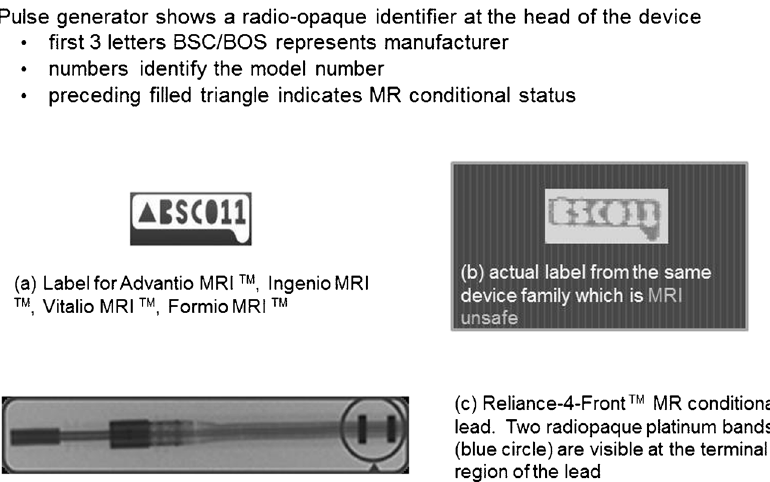
Fig. 9 Magnified radiographic images demonstrate radiopaque identifiers from BostonScientific devices a MR conditional devices b MRI unsafe devices and c MR- conditional lead. (images used with permission)